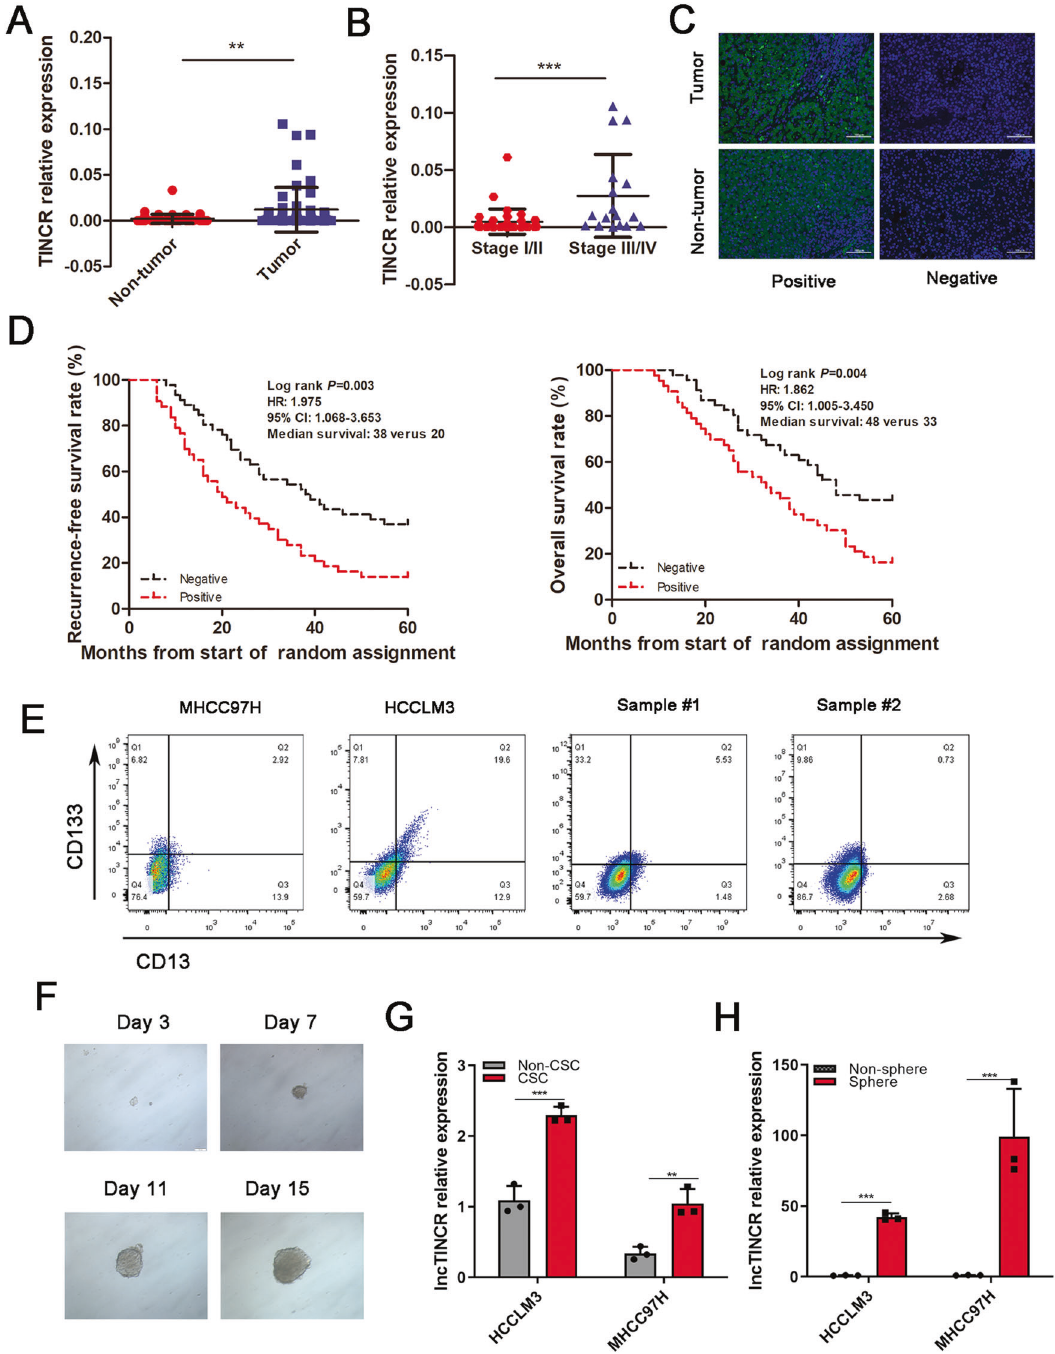
Fig. 1 TINCR was highly expressed in liver tissues and CSCs. A TINCR expression levels in HCC tissues were assessed by qRT-PCR assay. TINCR expression in tumor tissues were higher than the matched normal tissues ( p < 0.01). B The patients with III/IV stage exhibited higher TINCR expression in tumor tissues than those with stage I/II. C TINCR expression was determined by ISH assay. Representative images of TINCR in HCC and adjacent tissue are shown. Scale bar, 100 μ m. D RFS and OS of HCC patients in validation cohort. Patients with positive TINCR expression had shorter RFS ( p = 0.003) and OS ( p = 0.004). E CD133 + CD13 + subpopulations were sorted by fl ow cytometry from HCCLM3, MHCC97H HCC cell lines, and primary tumor cells. F Typical microscope images of spheres in HCCLM3 cells. Scale bar, 100 mm. G TINCR